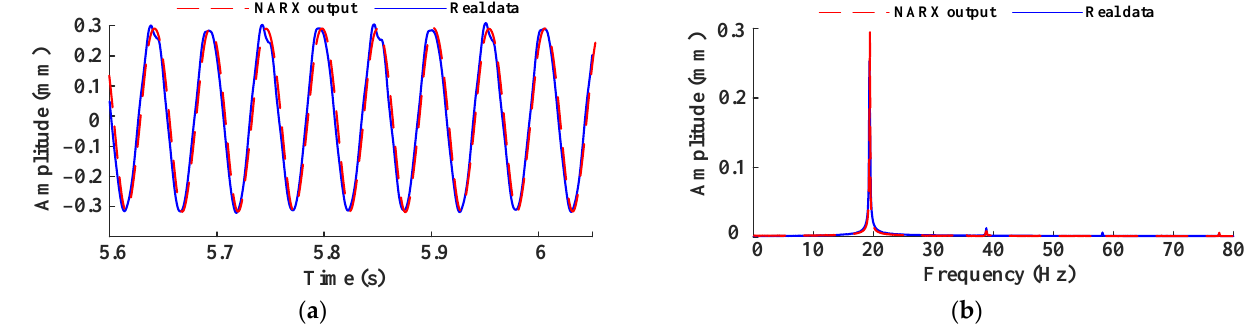
118.1 rad/s ω ): ( a )